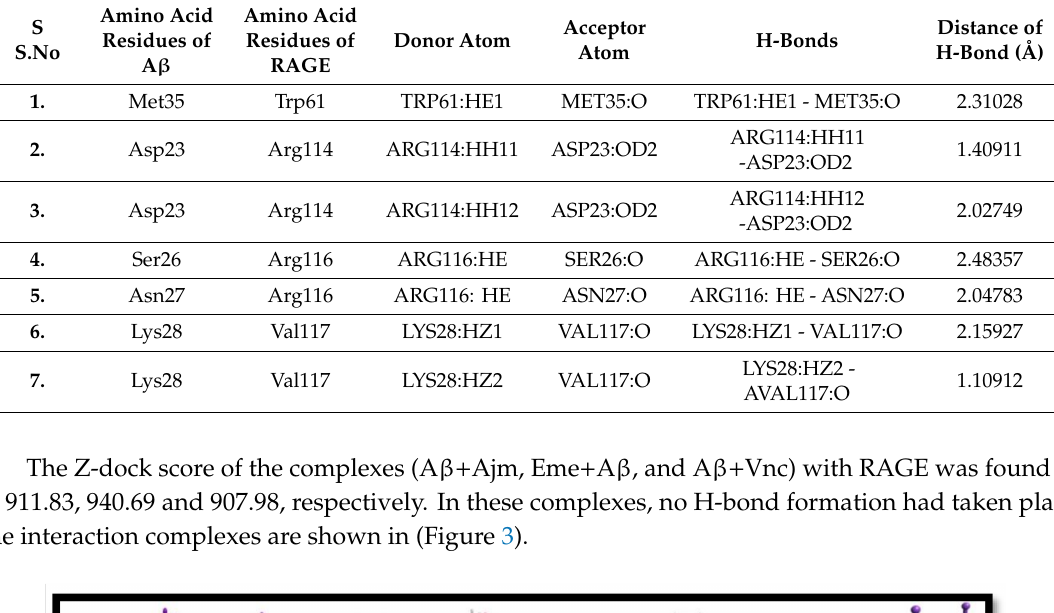
Table 3. Acid residues involved in hydrogen bond formation in the protein-protein interaction.